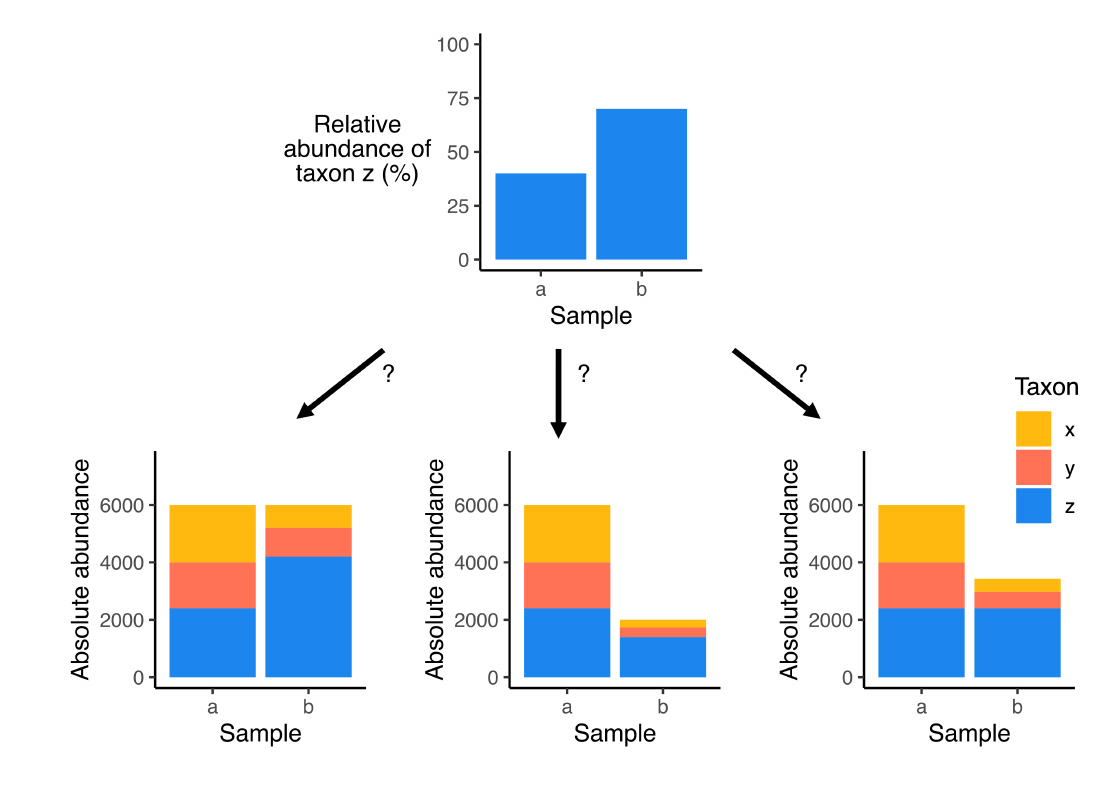
Figure 2: Microbiome sequencing data provides information only on relative abun- dances . This is because the data are compositional, meaning that it is constrained to sum to some arbitrary number, rather than corresponding to actual absolute abundances (e.g., cell counts or colony forming units). This illustrated example highlights how a difference in relative abundance in a given taxon, taxon z, between two samples does not provide information on whether there is a difference in terms of the absolute abundance of this taxon (except for certain circumstances noted in the main-text). From bottom left to right three possible configurations of absolute abundance are shown. The left panel shows the case where the total abundance of taxa is the same in each sample and so taxon z is indeed at higher absolute abundance in sample b. However, it is also possible that the absolute abundance of this taxon could be lower (bottom centre) or the same (bottom right) depending on the total absolute abundance in each